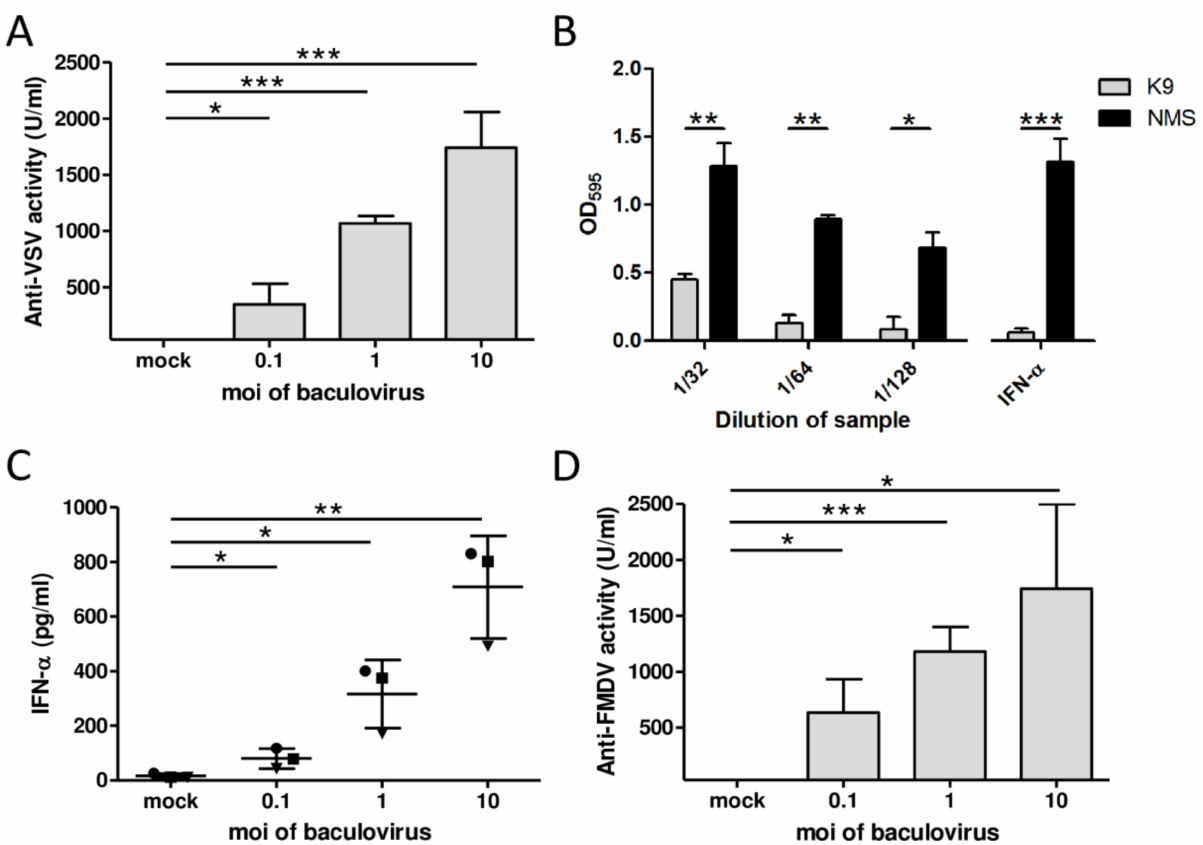
Figure 1. AcMNPV elicits IFN- α -mediated antiviral activity in porcine PBMCs in vitro. PBMCs from three piglets were either mock infected or infected with AcMNPV for 18 h and supernatants were subsequently collected. ( A ) The antiviral activity against VSV serotype Indiana of the supernatants was assayed in MDBK cells. ( B ) Dilutions of supernatants from PBMCs infected with AcMNPV or standard porcine IFN- α (100 U/mL) as control were pretreated with neutralizing anti-IFN- α antibodies or NMS at room temperature for 1 h and assayed for antiviral activity in a bioassay in MDBK cells against VSV infection. The samples were fixed and the assay was revealed with crystal violet; the dye was resuspended and read at 595 nm. ( C ) IFN- α levels were quantified by ELISA. Each symbol represents PBMCs from a distinct pig. ( D ) Antiviral activity against FMDV O1 Campos in the samples was assayed in LFBK cells. Standard porcine IFN- α was used for the quantification of antiviral activity units in A and D (1 U corresponds to 2.16 pg IFN- α ; IC 50 ~ 7.22 U/mL). The results are from an experiment that is representative of at least two independent experiments. One-sample t -test was performed to identify differences in antiviral activity between supernatants from AcMNPV- and mock-treated cells. Student’s t -test was performed to compare IFN- α between AcMNPV- and mock-treated cells or antiviral activity between samples pretreated with anti-IFN- α K9 mAb and those pre-treated with NMS. * p < 0.05; ** p < 0.01; *** p <